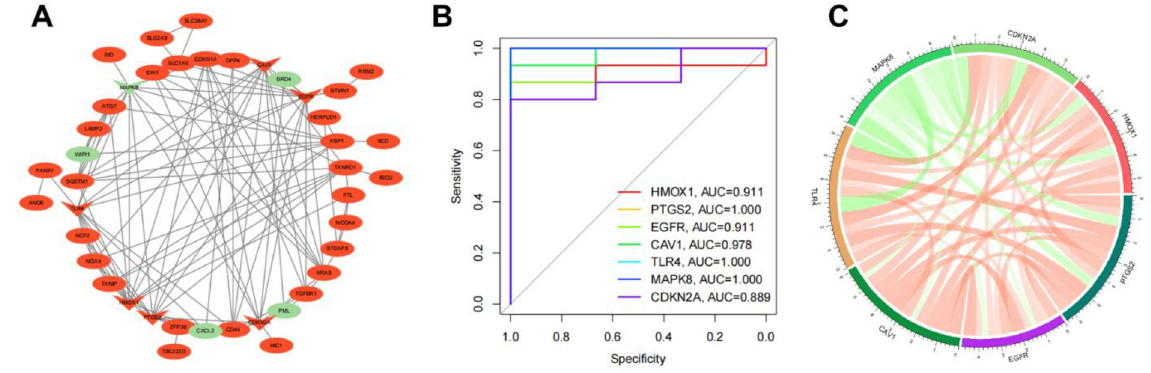
Fig 5. PPI Network of DE-FRGs and hub gene detection. (A) PPI network of 52 DE-FRGs. Green represents downregulated genes, and red represents upregulated genes. V shape represents the hub genes; ellipse represents others. (B) ROC curves of the seven genes for the diagnosis when distinguishing DR from normal. (C)Red represents positive correlation, green represents negative correlation, and the darker the color or the thicker the line, the higher the correlation intensity.